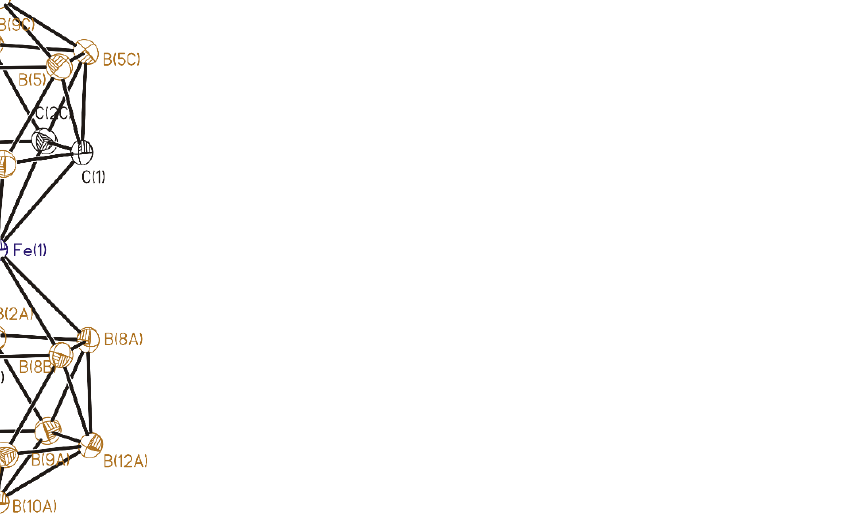
Figure 3. Anion in ( 2 ). Thermal ellipsoids are given at 30% probability level. Cage H atoms omitted for clarity.